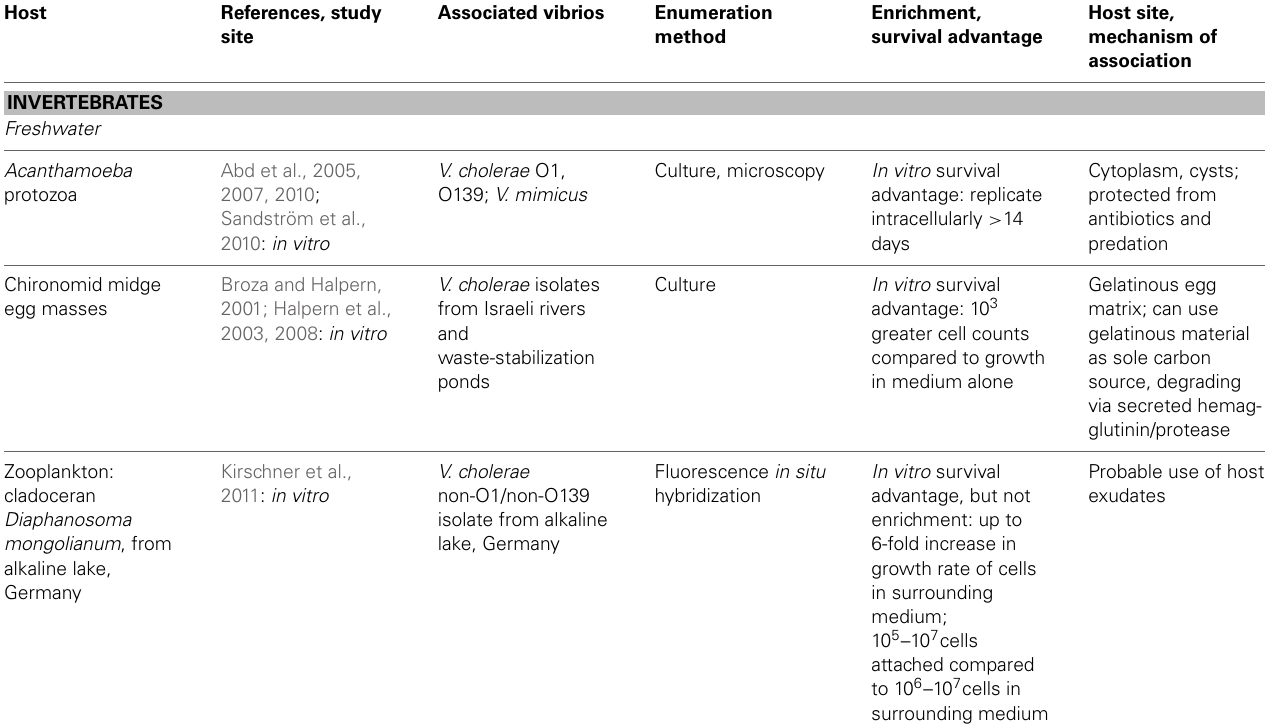
Table 2 | Animal hosts for vibrio, as demonstrated by numerical enrichment and biological mechanisms supporting